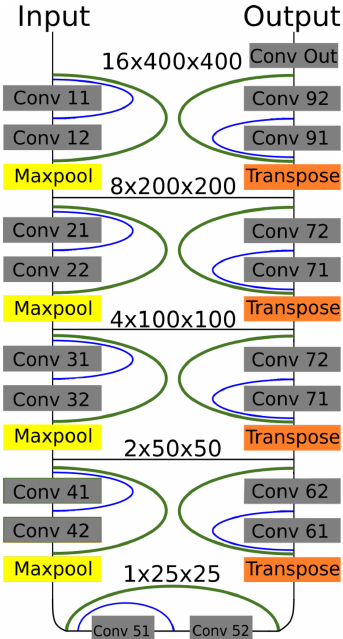
Figure 6. Dense-U-Net network model. Residual interconnections are in green color, dense interconnections in blue. Feature sizes are valid for batches of images from brain dataset.